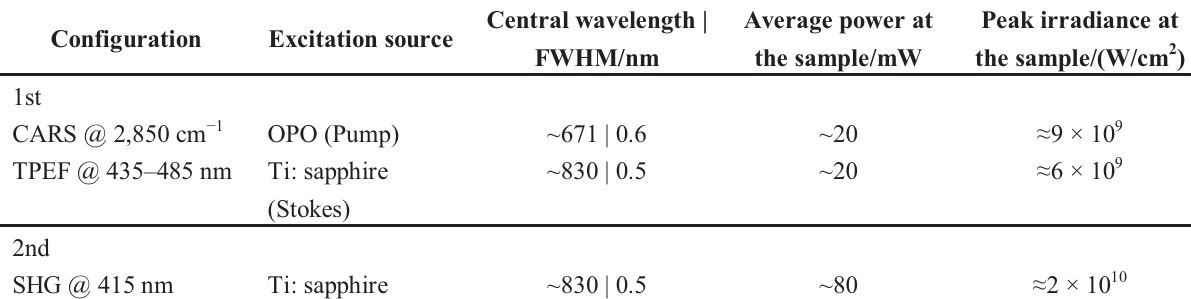
Table 1. Overview of the experimental